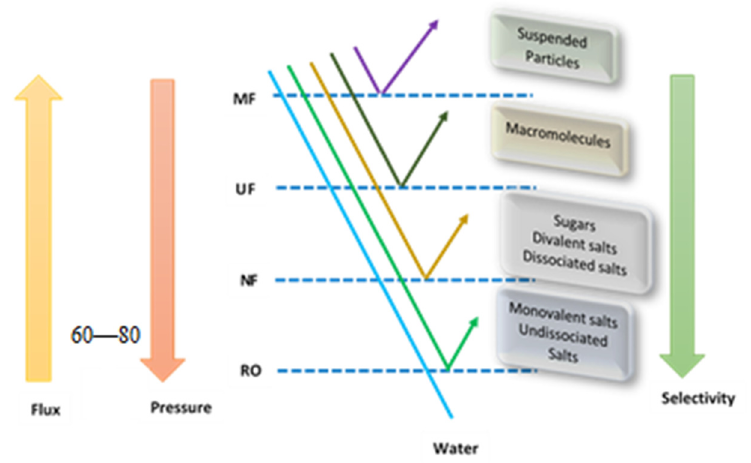
Figure 1. Various pressure-driven membrane processes.